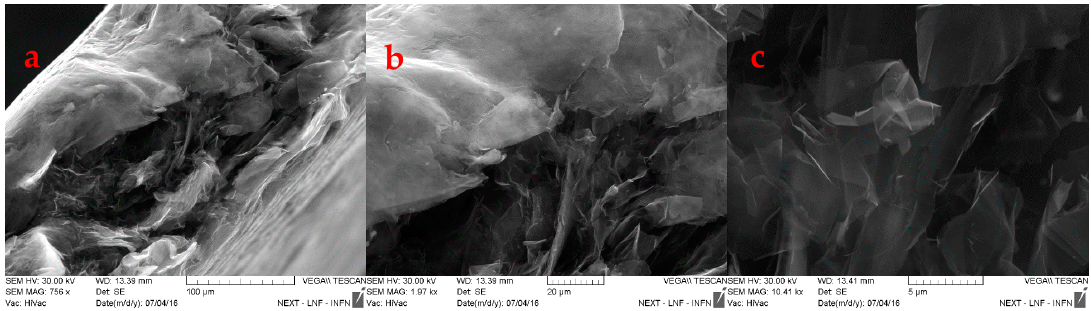
Figure 6. SEM images of sample 4 at different magnifications.